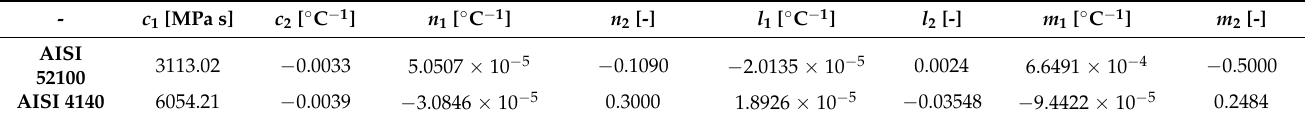
Table 2. Calibrated GMT model parameters for AISI 52100 and AISI 4140.